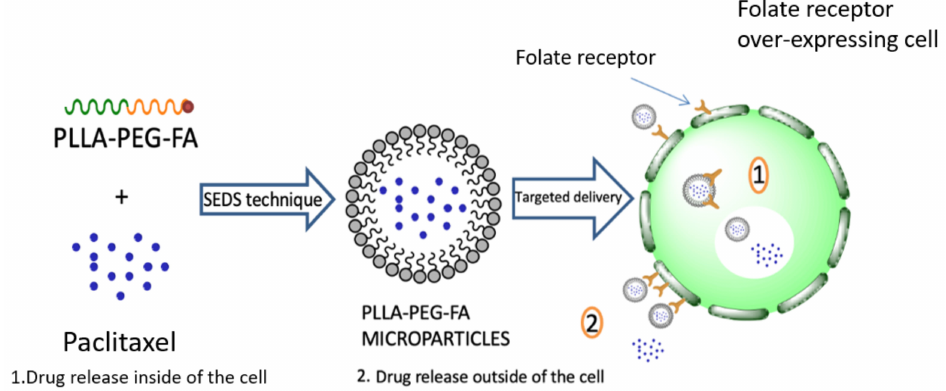
Figure 15. A scheme of folate receptor mediated target delivery of PTX using FA-PEG-PLLA copoly- mer